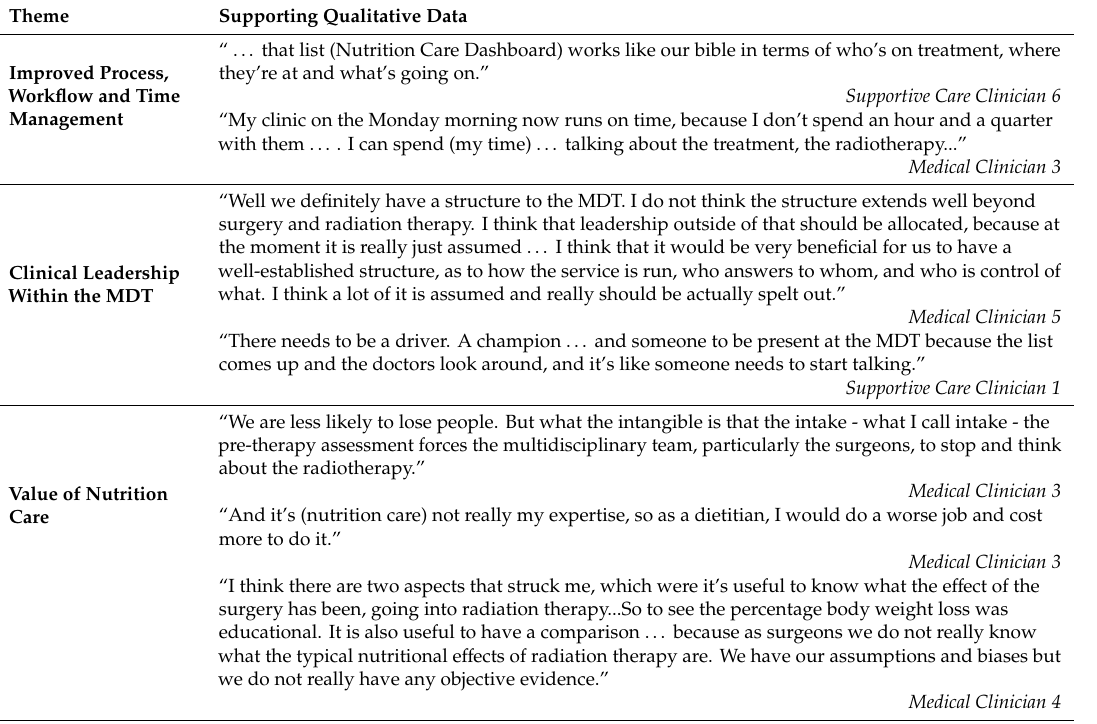
Table 4. Qualitative analysis—key themes identified through focus groups with head and neck oncology multidisciplinary team members (N =